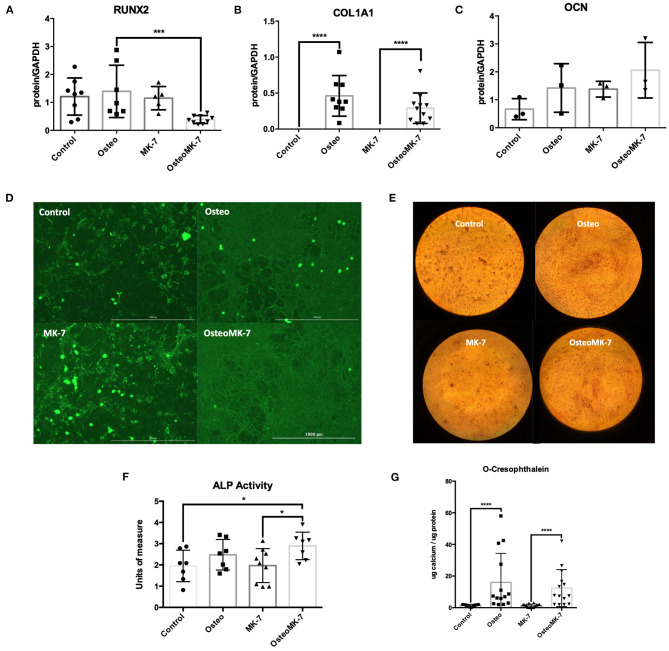
Protein expression at late osteoblast differentiation. Western blotting following 21 days differentiation for RUNX2 shows that following 21 days osteogenic treatment with MK-7 that RUNX2 is significantly downregulated compared to other samples (A) (p = 0.0003). Collagen 1A1 is upregulated in osteogenic conditions without any difference compared to MK-7 supplementation and OCN has no difference in expression (B,C) (p ≤ 0.0001). Immunocytochemistry staining for COL1A1 shows that a completely different mode of collagen deposition has occurred following osteogenic treatment, although there are nodules present in the control and control MK-7 treated cells that resemble COL1A1 osteogenic deposition (D). Representative photos of the cells stained with Alizarin Red at day 21 (magnification 10x) (E). At day 21 control, osteogenic and MK-7 treated groups show no difference in ALP levels. Only osteogenic media supplemented with MK-7 was able to induce significant upregulation in ALP activity (F) (p = 0.0418). Quantification of calcium deposition by o-cresophthalein assay at day 21 (G). *p < 0.05, ***p < 0.001, ****p < 0.0001.